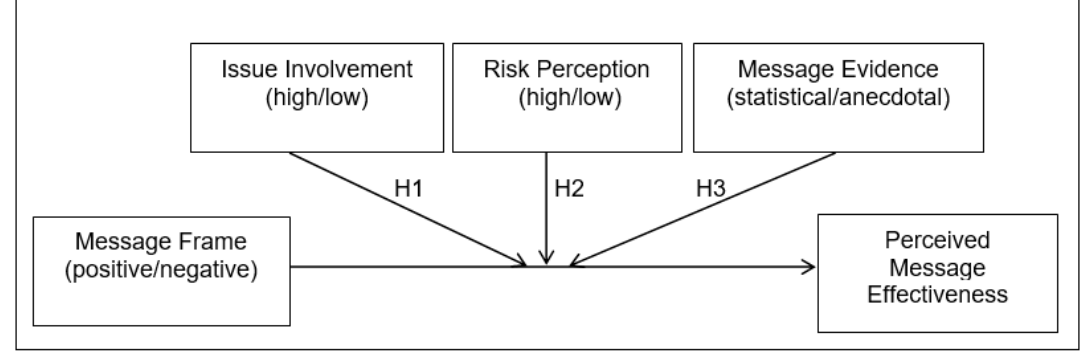
Figure 1. Research Figure 1. Research framework.